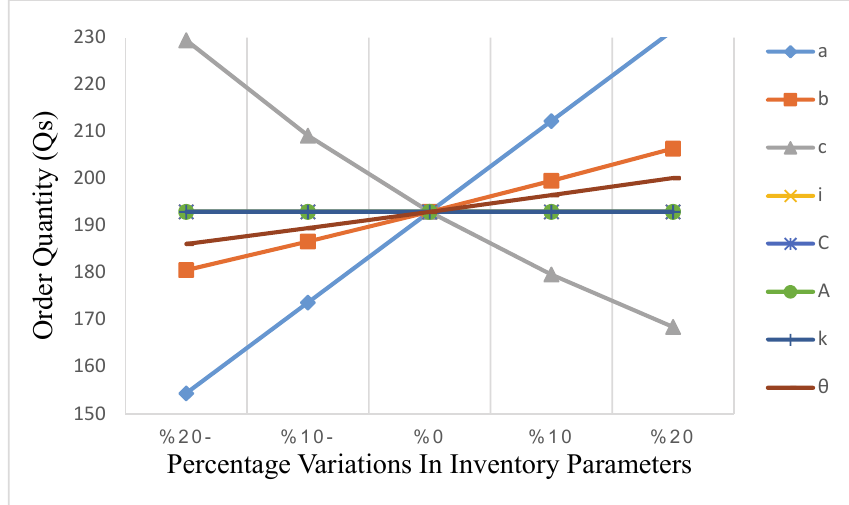
Fig. 9. Variations in order